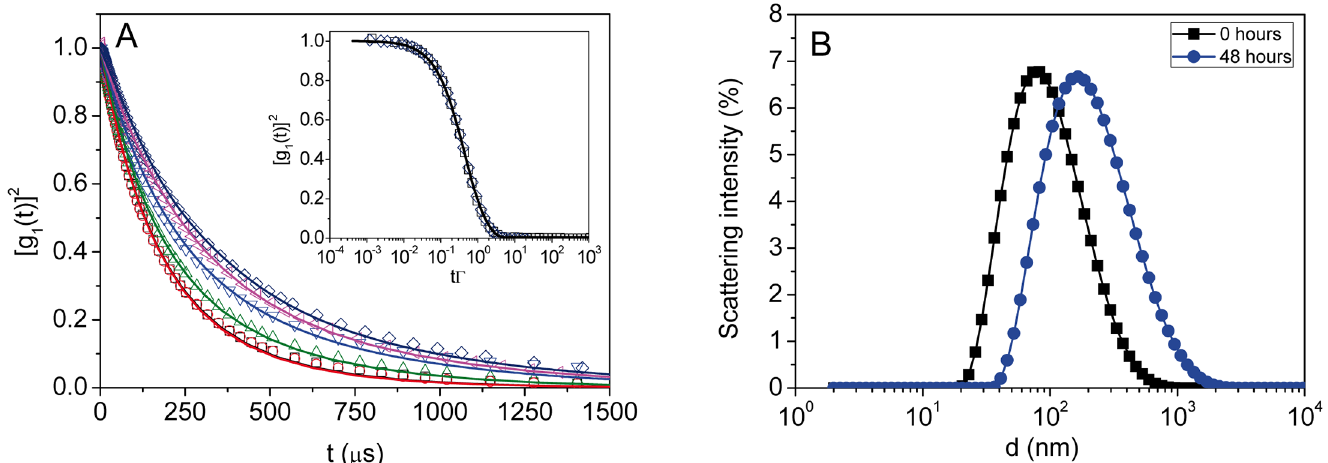
Fig 1. Experimental results obtained from Dynamic Light Scattering experiments. (A) Squared electric field time autocorrelation function, [g 1 (t)] 2 , of the HPV16 VLPs at T = 298 K versus time: ( ◻ , black) 0 h, ( (cid:6) , red) 1 h, ( 4 , green) 2 h, ( 5 , blue) 6 h, ( ◁ , magenta) 12 h, ( ▷ , cyan) 24 h and ( (cid:7) ,navy) 48 h. The lines represent the cumulant fits given by Eq (3) of the experimental results. The insert shows the fit for initial (0 h, ◻ ) and final (48 h, (cid:7) ) samples in the log-time scale reduced coordinates (t Γ ). (B) Intensity distributions determined from DLS results for ( ∎ ) initial and ( ● , blue) final VLPs. Each measurement is an average of 15 scans.